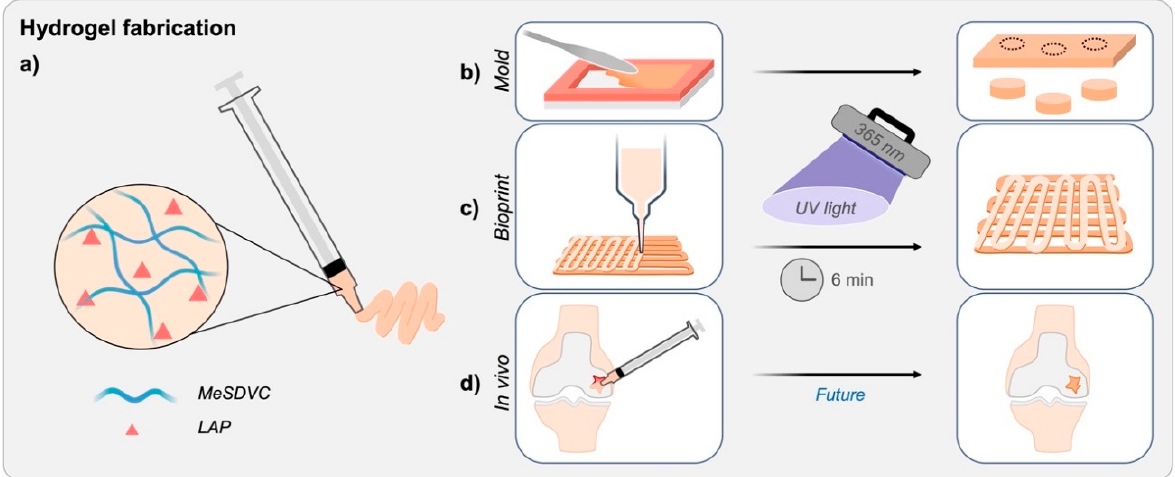
Figure 2. Illustration of the applications of the paste-like cartilage hydrogel precursor and photocrosslinking hydrogel. ( a ) The methacryloyl-functionalized and solubilized devitalized cartilage (MeSDVC) precursor is comprised of only MeSDVC and a photoinitiator, LAP. The paste-like precursor was easily loaded into syringes for ease of application. The paste-like MeSDVC precursors ( b ) were loaded into molds and ( c ) were printed. After exposure to UV light (365 nm) for 6 min, the precursors photocrosslinked into a stiff hydrogel. Hydrogels formed in molds were biopsy-punched out for hydrogel characterization (e.g., swelling, stiffness), and printed structures were characterized (e.g., pore areas and strut size measurements) or seeded with cells. ( d ) In the future, the MeSDVC paste-like precursor may prevent material leakage from a cartilage defect and the quick in situ crosslinking may enable the formation of a high-modulus hydrogel, similar to native cartilage, to support an immediate return to weight-bearing activities.